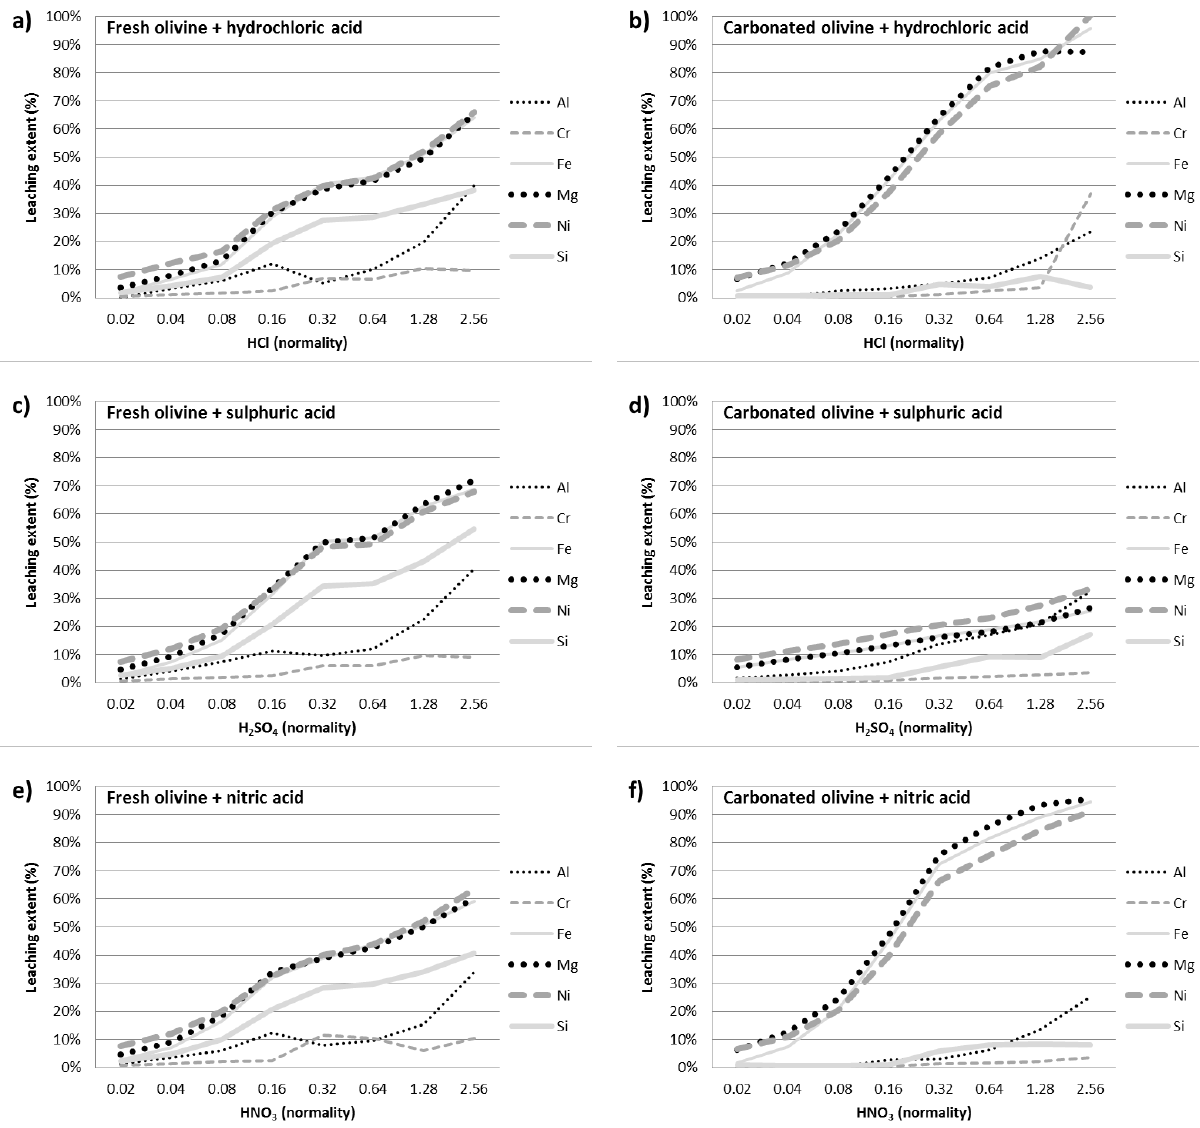
Figure 9. Leaching extent from fresh ( a , c , e ) and carbonated ( b , d , f ) olivine with hydrochloric ( a , b ), sulfuric ( c , d ) and nitric ( e , f ) acids; Tables S2 and S3 provide statistical data on